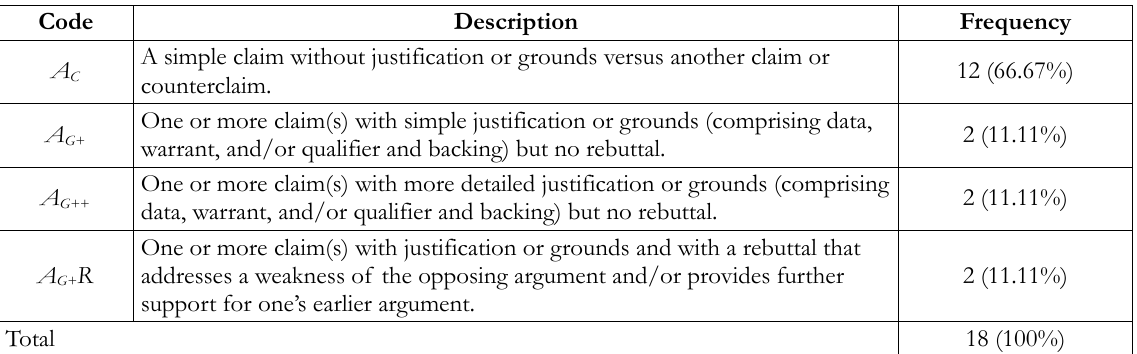
Table 4. Students’ scientific argumentation in the Identification of the potential solution